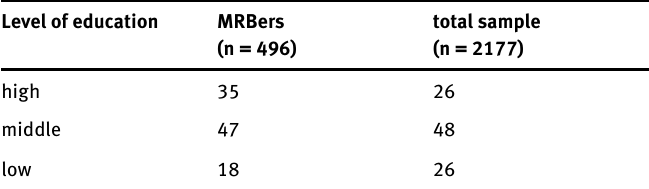
Table 14. Level of education of